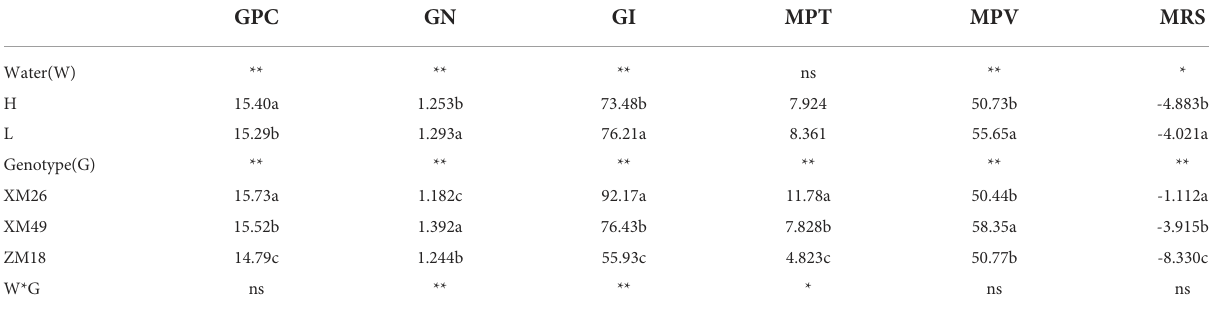
TABLE 2 Grain quality parameters of different winter wheat genotypes under the different irrigation treatments and results of the analysis of variance. GPC GN